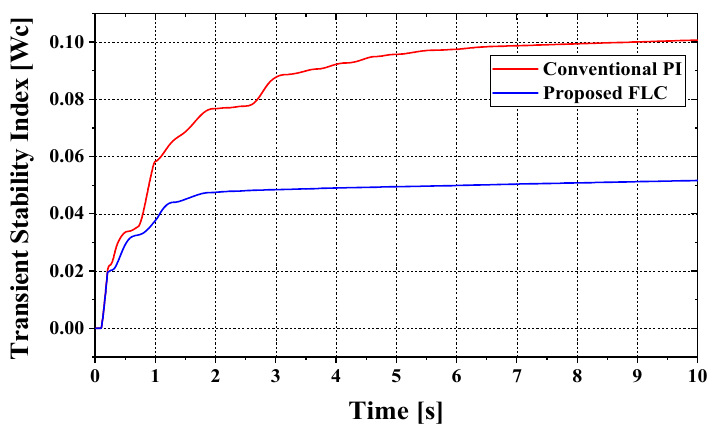
Figure 16. Profile of the transient stability index for SGs.